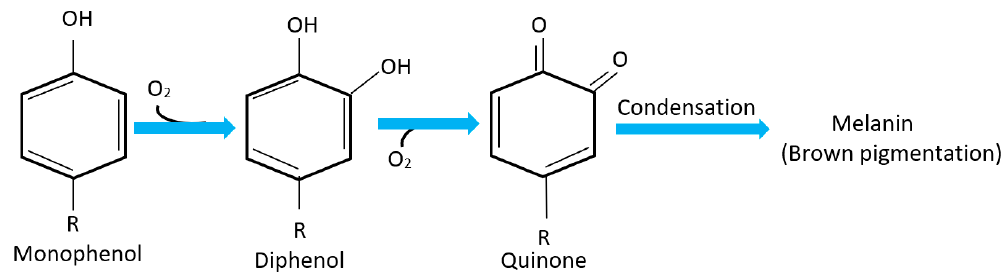
Figure 3. Polyphenol oxidase (PPO) reaction responsible for browning in vegetables.